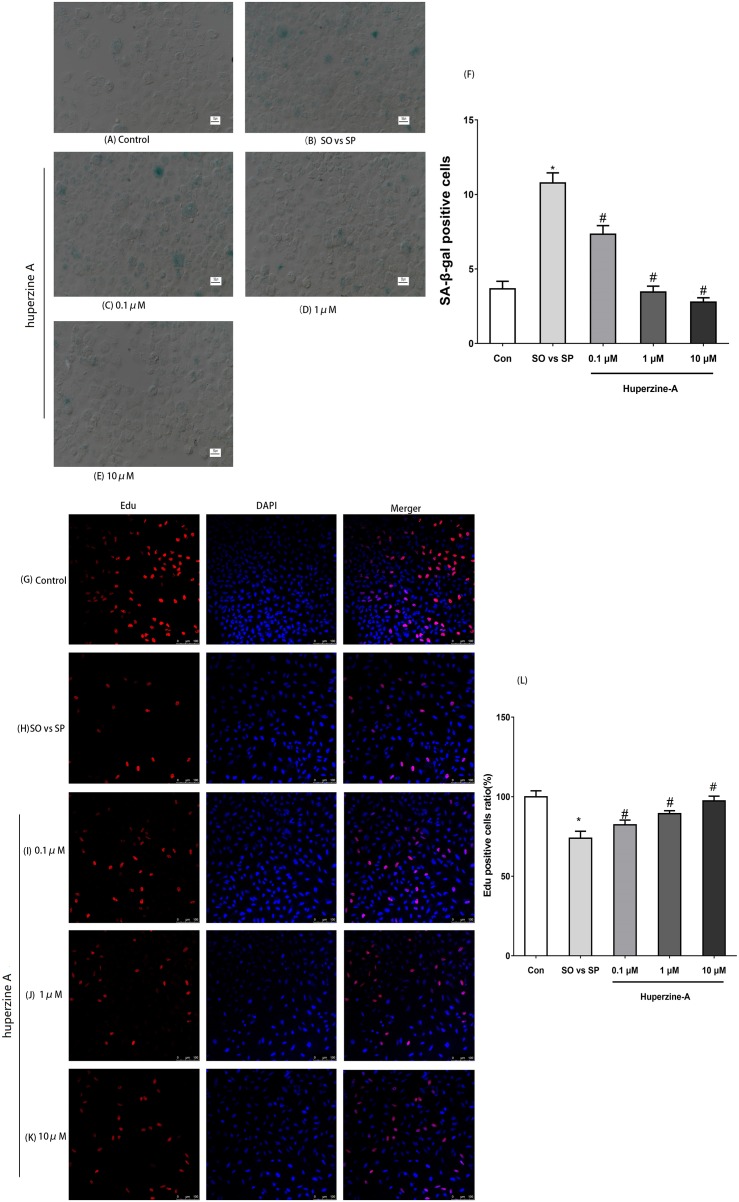
The expression of SA-β-gal and Edu by immunofluorescence labeling.(A–F) L-02 cells were treated with FFA, FFA + LH, FFA + MH and FFA + HH for 24 h. The expression of SA-β-gal determined by immunofluorescence labeling. Quantitative analysis of SA-β-gal-positive cells in the five groups by the ratio of SA-β-gal-positive cell number to the total and normalized to the controls. The expression of the SA-β-gal-positive cells was nearly threefold in the FFA group compared with in the control group (P < 0.01), but reversed in the FFA + LH, FFA + MH and FFA + HH groups (P < 0.01). (G–L) The expression of Edu was detected by immunofluorescence labeling. Quantitative analysis of Edu-positive cells in the five groups by the ratio of Edu-positive cell number to the total and normalized to the controls. The expression of Edu in the FFA group was lower than in the control group (P < 0.01). The expression levels were all higher in FFA + LH, FFA + MH and FFA + HH groups than in the FFA group (P < 0.01), but with no significant difference among FFA + LH, FFA + MH and FFA + HH groups (P > 0.05). Data presented as the mean ± SE (n = 3 independent replicates). *P < 0.05 vs. control; #P < 0.05 vs. FFA models; FFA mixture: 0.5 mmol/L, sodium oleate (SO)/sodium palmitate (SP) mixed at a 2:1 ratio; LH: FFA + 0.1 μmol/L huperzine A; MH:FFA + 1.0 μmol/L huperzine A; HH:FFA + 10 μmol/L huperzine A.